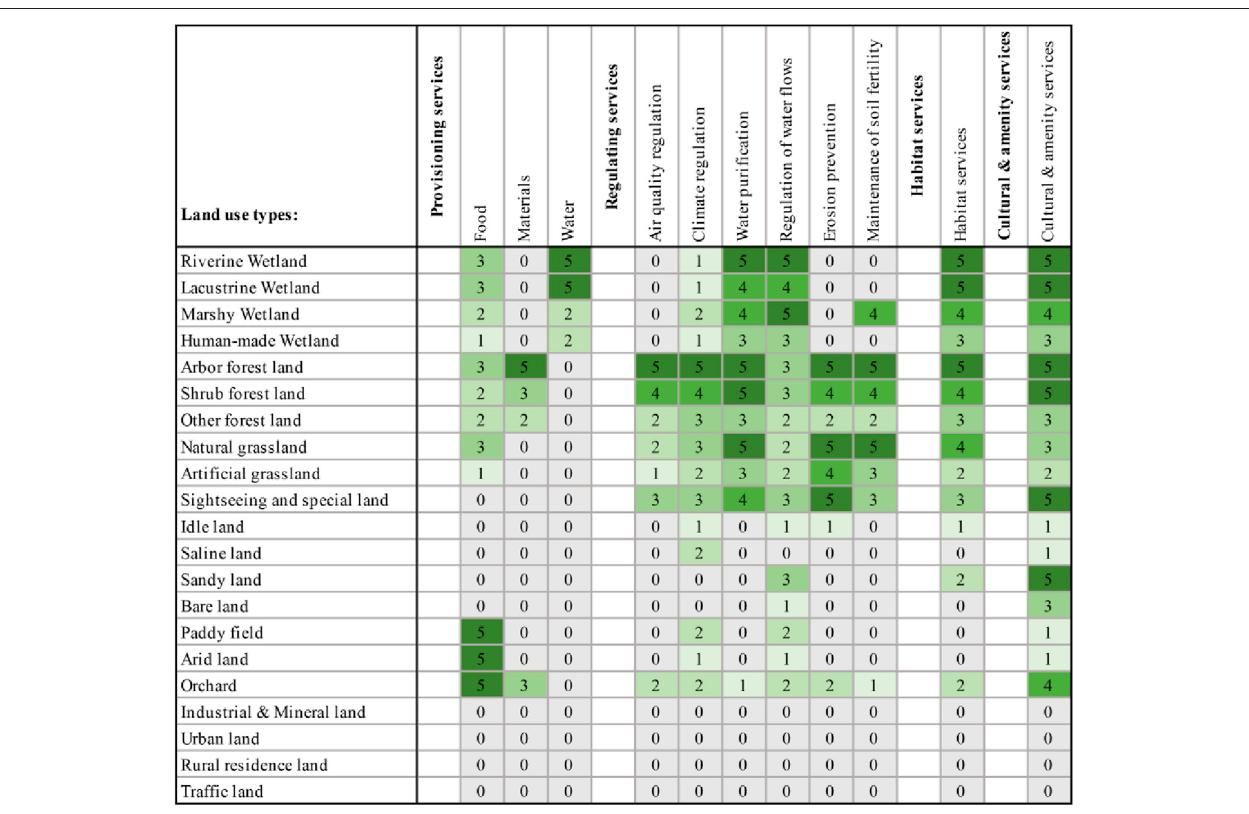
FIGURE 1 | Assessment matrix of the supply potential of ecosystem services within the different land use types. The values indicate the following potentialities: 0 (cid:1) no relevant potentiality; 1 (cid:1) very low relevant potentiality; 2 (cid:1) low relevant potentiality; 3 (cid:1) medium relevant potentiality; 4 (cid:1) high relevant capacity; and 5 (cid:1) very high relevant